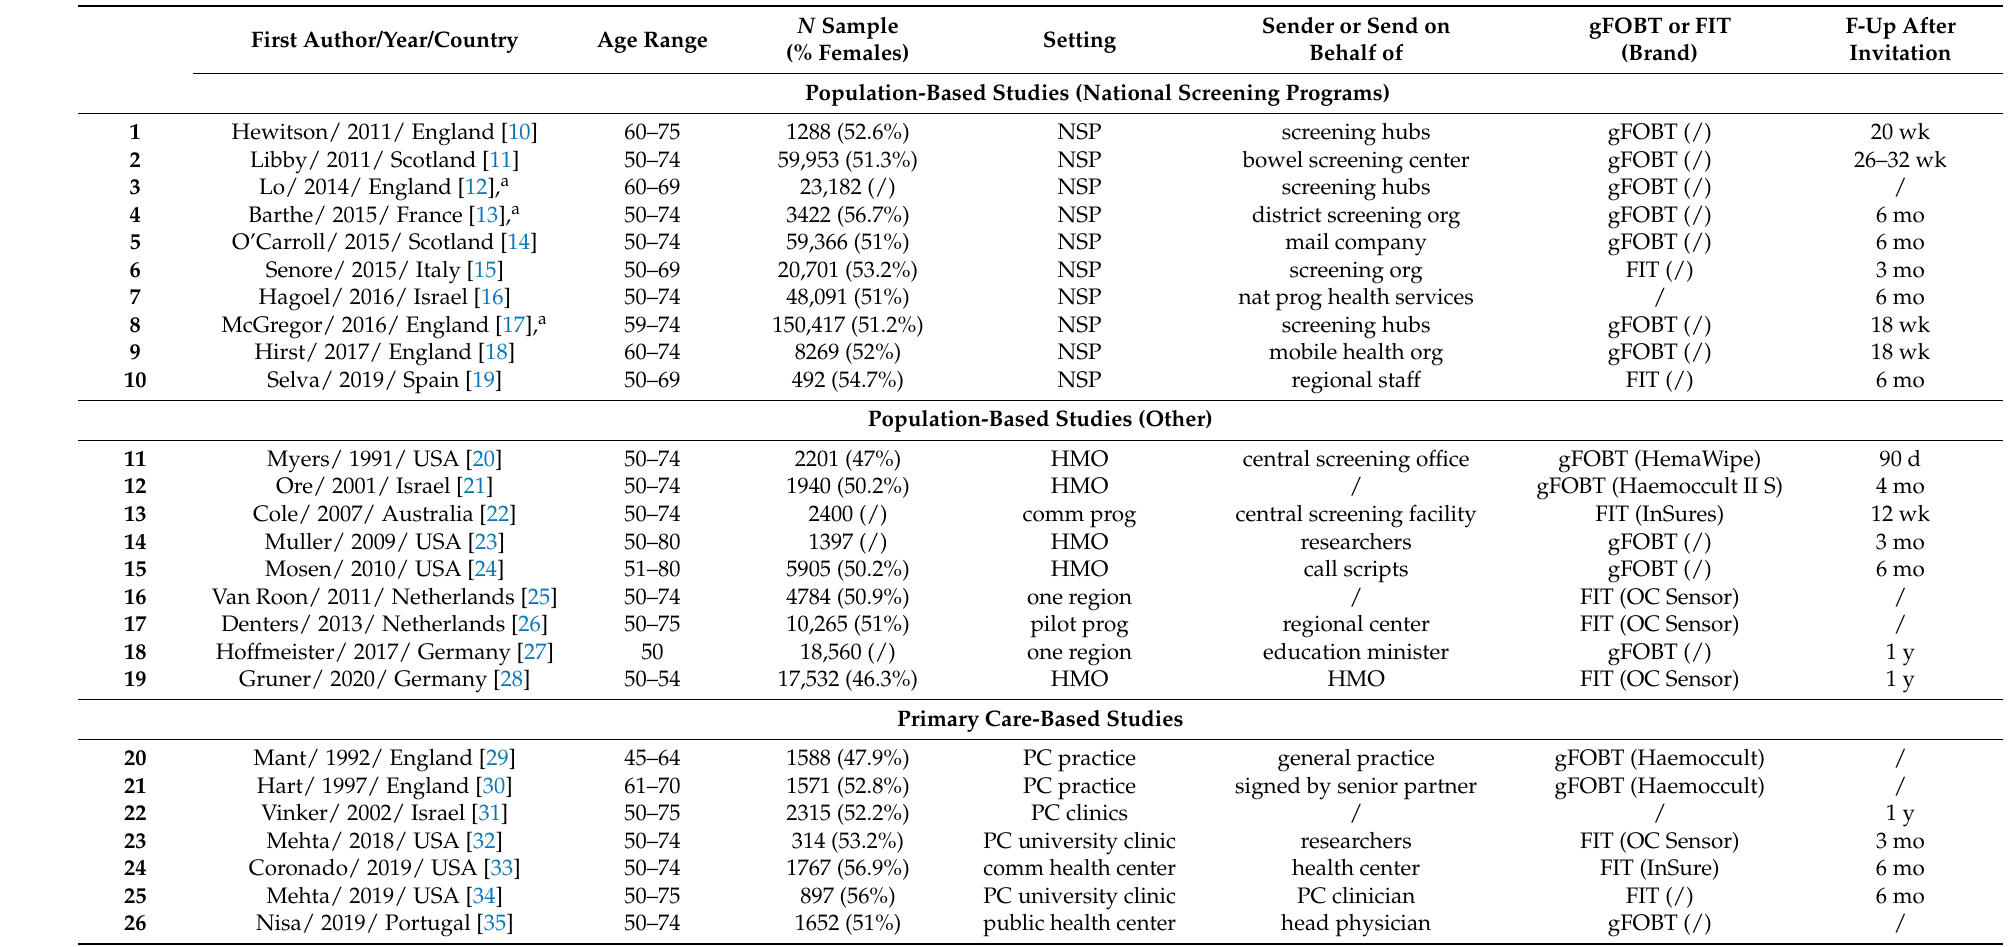
Table 1. Characteristics of randomized and cluster-randomized studies included in systematic